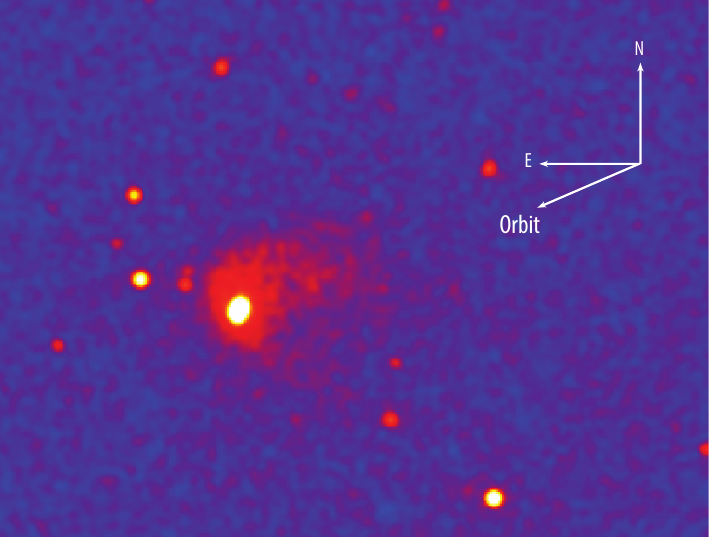
Figure 6. UVOT V-band imaging of the aftermath of the impact on asteroid 596 (Scheila). Two plumes are visible, containing a total of 6 × 10 8 kg of ejected dust. UVOT grism spectroscopy ruled out that the plumes contained water vapor, implying that the activity was triggered by a collision with a small asteroid [6]. The asteroid’s orbital direction and the direction to the Sun are approximately